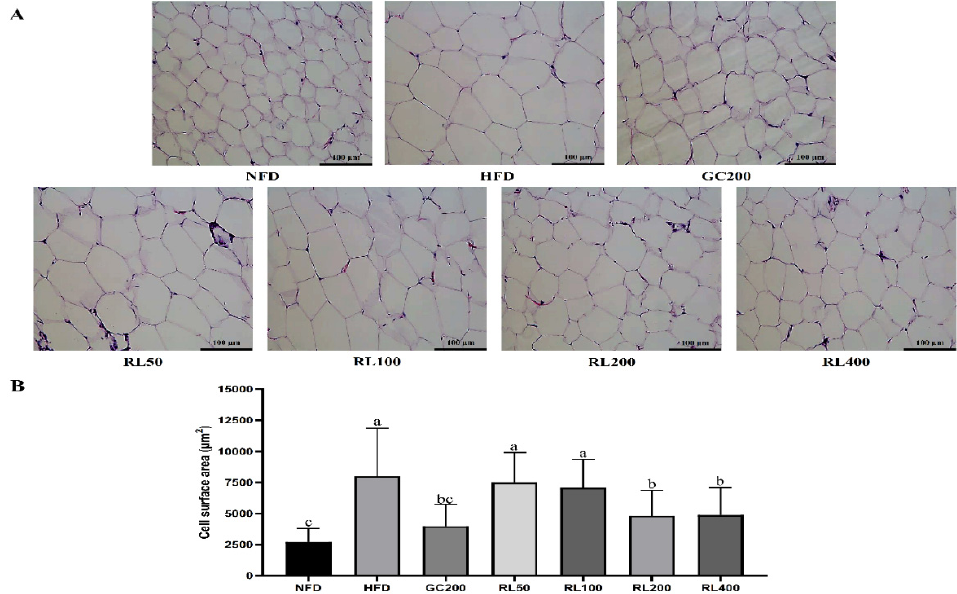
Figure 5. E ff ects of RL at various concentrations on the size of adipocytes in epididymal adipose. ( A ) hematoxylin–eosin staining of epididymal adipose tissue; ( B ) stained adipose tissue cell area estimated by Adiposoft software. RL—red ginseng and licorice extracts mixed at a 3:1 mass ratio; NFD—mice fed normal-fat diet (10% kcal fat); HFD—mice fed high-fat diet (60% kcal fat); GC200—HFD + 200 mg / kg / day of Garcinia cambogia water extract; RL50—HFD + RL at a concentration of 50 mg / kg / day; RL100—HFD + RL at a concentration of 100 mg / kg / day; RL200—HFD + RL at a concentration